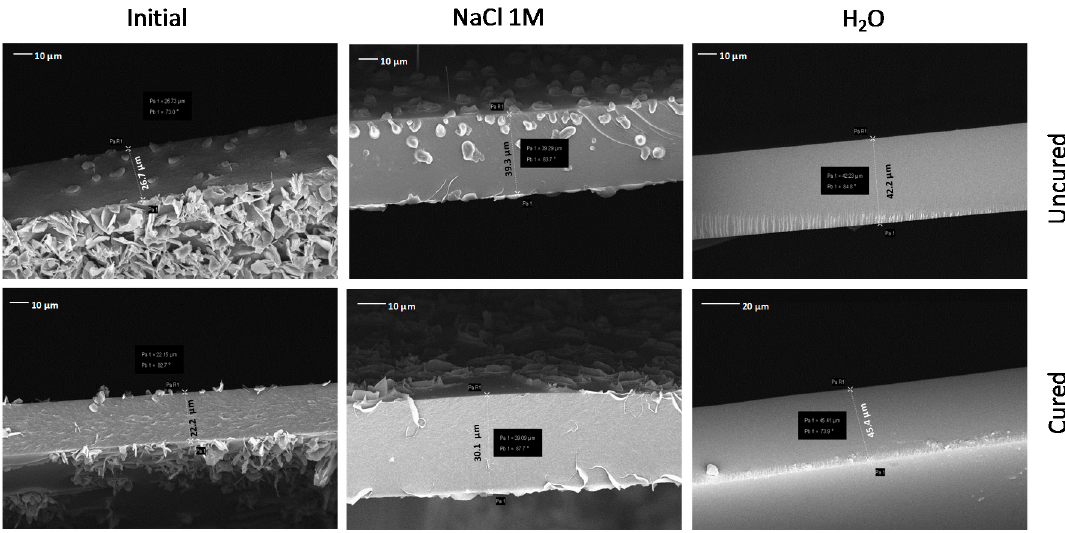
Figure 9. Scanning electron microscopy (SEM) images of uncured C3 ‐ RT and cured C3 ‐ 120 polymeric coatings before and after immersion in ultra ‐ pure water and NaCl 1 M for 60 days.